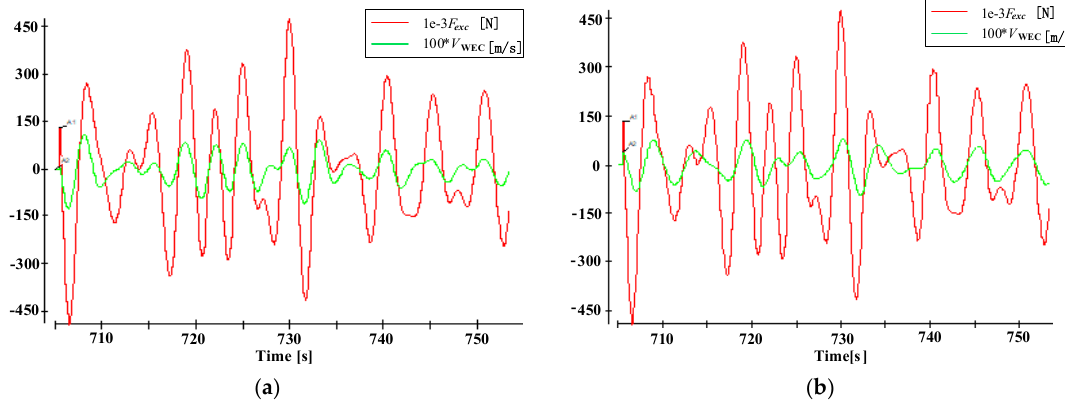
Figure 16. Measured excitation force and the velocity of buoy, ( a ) FPA and ( b ) hill-climbing method Table 4. Comparison of average power absorption and peak-to-average ratio in experiments. Case